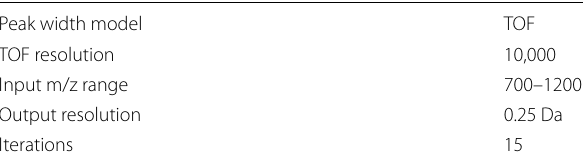
Table 1 MaxEnt1